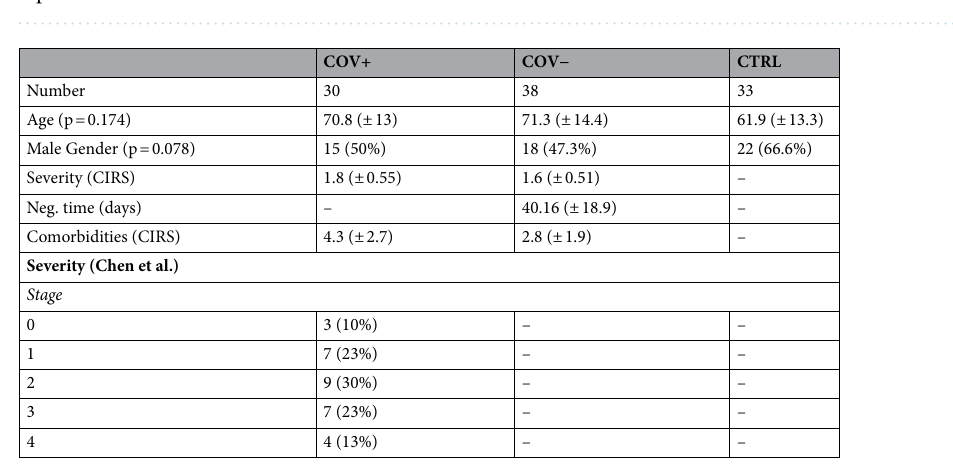
Figure 1. Average Raman spectra obtained from (a) healthy subjects (CTRL), (b) patients affected by COVID- 19 (COV +) and (c) subjects with at least two negative SARS-CoV-2 tests after being positive (COV−). (d) Overlapped average spectra of the three experimental groups highlighting spectral differences. The grey bands represent the standard deviations.